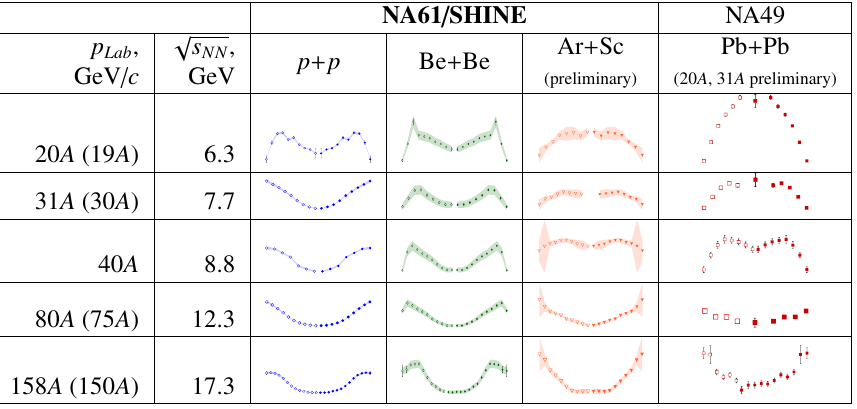
Table 1: System size and energy dependence of the shape of the proton rapidity spectra.